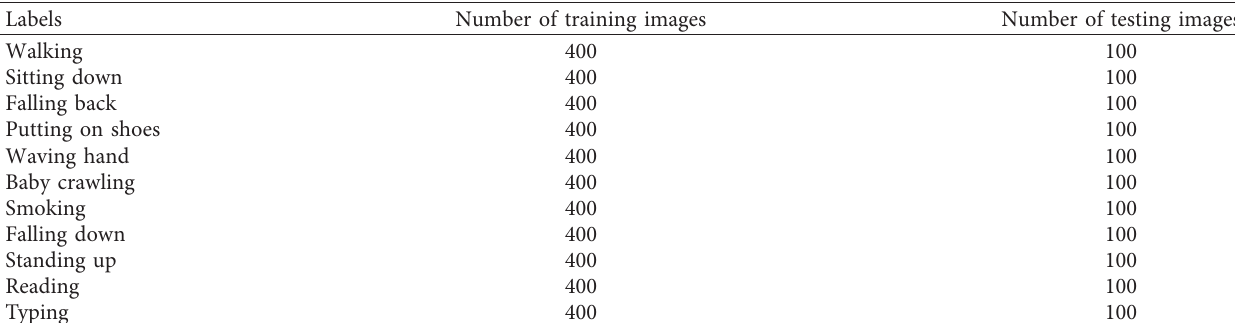
Figure 3: Prepare data for implementation: (a) putting on shoes, (b) falling back, (c) sitting down, (d) walking, (e) waving hand, (f) baby crawling, (g) smoking, (h) falling down, (i) standing up, (j) reading, and (k) typing. Table 2: Number of images and labels are prepared for